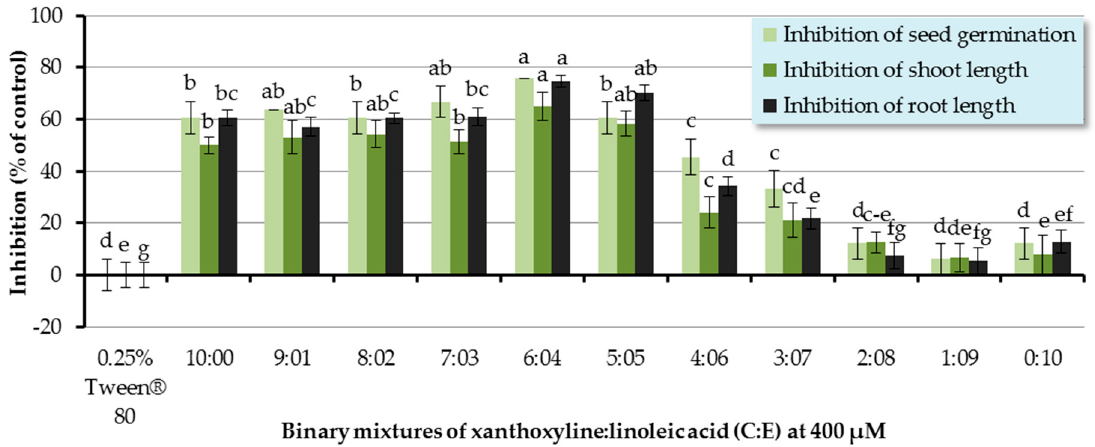
Figure 6. Inhibitory effects of binary mixtures (at 400 μ M) of linoleic acid ( E ) and xanthoxyline ( C ) on seed germination and shoot and root growth of Chinese amaranth. A 0.25% aqueous solution of Tween ® 80 was used as a control. Means with the same letters in the graph are not significantly different at p ≤ 0.05 level.